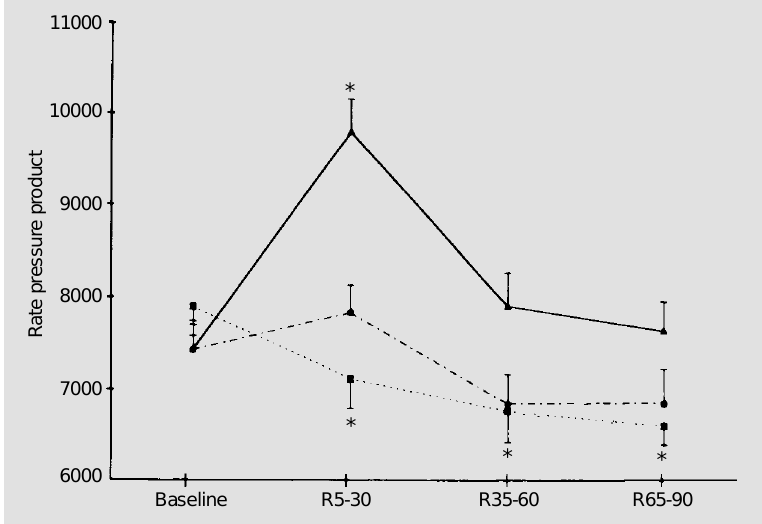
Figure 3 - Rate pressure product (heart rate x systolic blood pressure) at baseline and after exercise (R5-30, mean value between 5 and 30 min; R35-60, mean value between 35 and 60 min; R65-90, mean value between 65 and 90 min) performed at 30 (filled squares), 50 (filled circles) and 80% (filled triangles) of VO 2 peak. *P<0.05 compared to baseline (two- way analysis of variance for repeated measures and Scheffé ’ s post-hoc